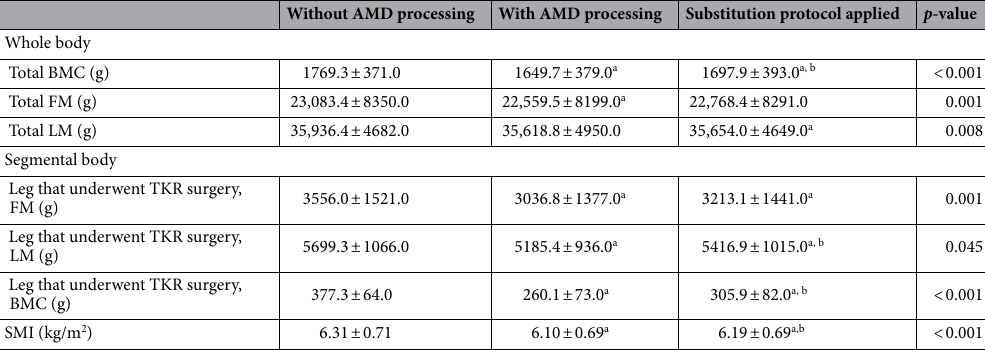
Table 3. Body compositions measured using whole-body dual X-ray absorptiometry according to automatic metal detection processing and application of substitution protocol among 10 study participants who underwent unilateral total knee replacement only. Substitution protocol: substituting the LM of the leg that underwent TKR with that of the leg that did not undergo TKR. AMD automatic metal detection, BMC bone mineral content, FM fat mass, LM lean mass, TKR total knee replacement, SMI skeletal muscle mass index. a Statistically significant difference between results without and with AMD processing and between results with AMD processing and substitution protocol application. b Statistically significant difference between results with AMD processing and substitution protocol